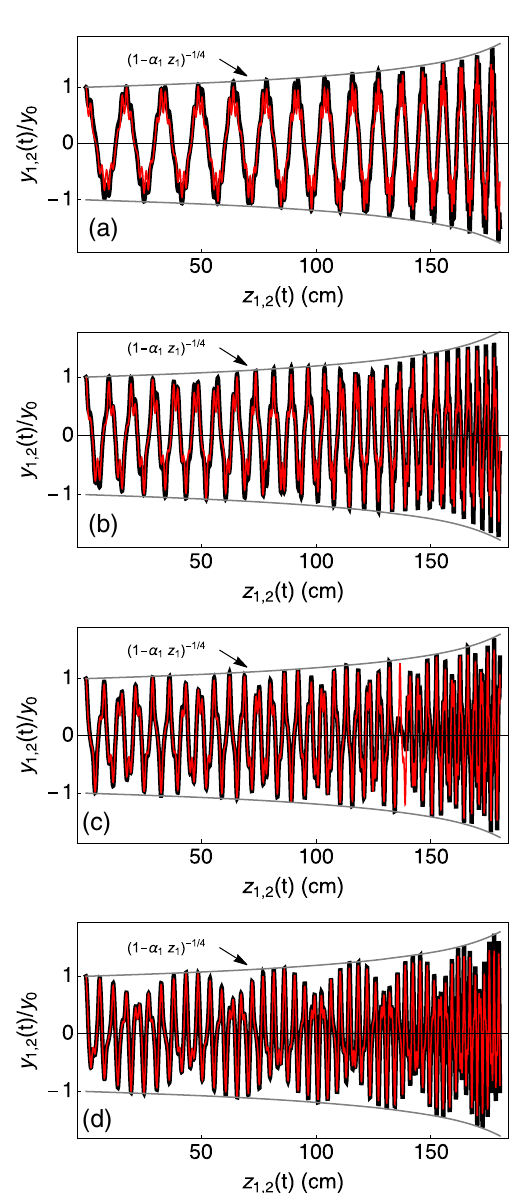
TABLE I. Parameters for the simulation. FIG. 6. Trajectories y 1 ; 2 ð t Þ of a first particle (black) and second